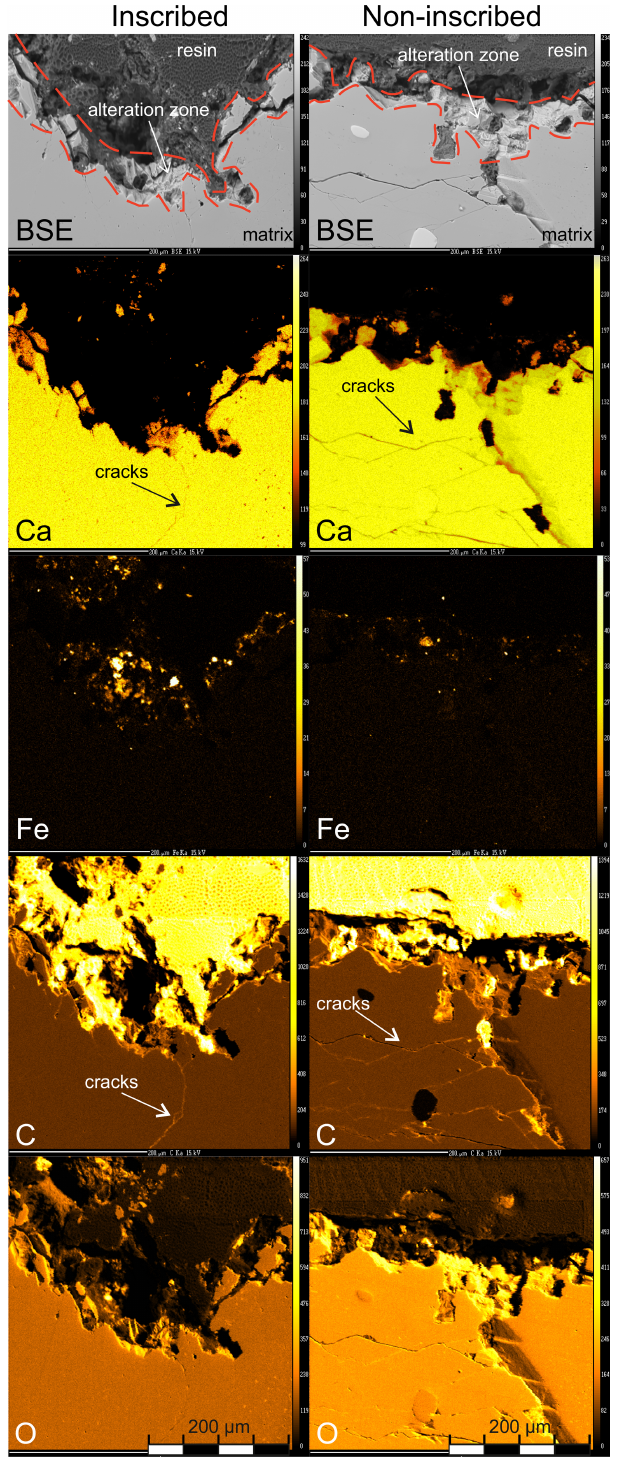
Figure 5. Backscattered electron (BSE) image and maps of selected elements of a polished cross section of sample AM_C1 (Asia Mi- nor) beneath and away from engraved letters. Dashed lines trace the altered surface layer; note that the difference in the thickness of the altered layers is not statistically